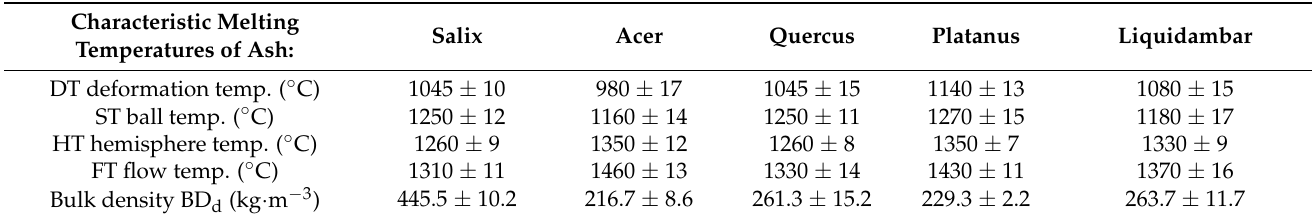
Table 5. Characteristics of the ashes obtained - mean values and standard deviations ( ± ). Characteristic